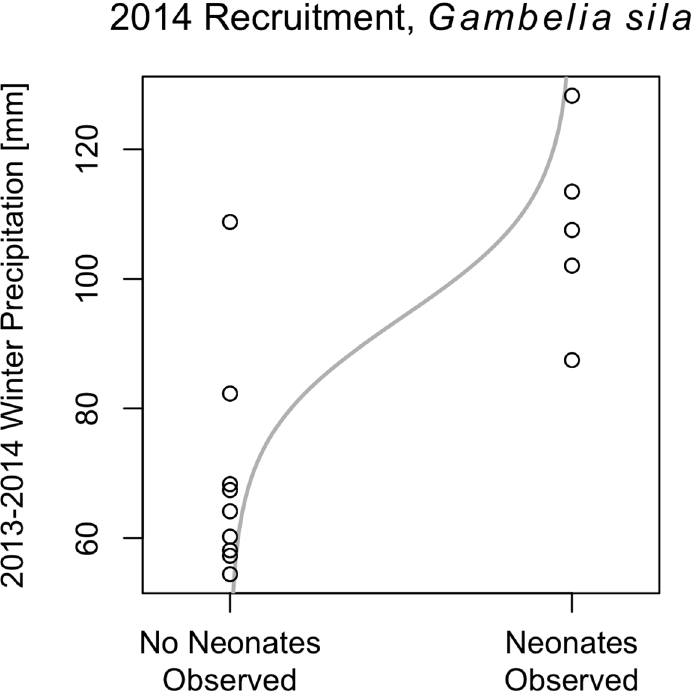
Fig 1. Sites where neonate G . sila were and were not observed plotted against winter precipitation. The line is predicted probability of observation as derived from a logistic regression fit to the data.